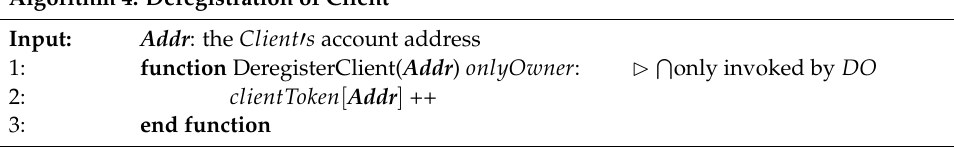
Algorithm 4. Deregistration of